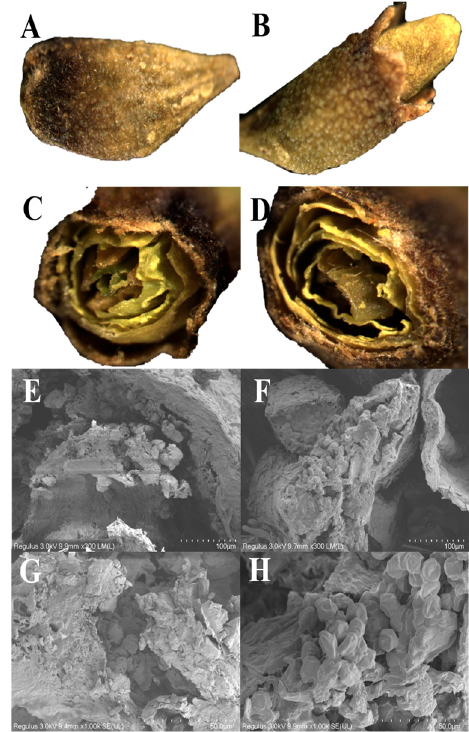
Figure 2. Stereomicroscope of ( A ) VD, 2×, ( B ) UAVD, 2×, ( C ) VD, 5×, and ( D ) UAVD, 5×. Scanning electron micrographs of ( E ) VD, 300×, ( F ) UAVD, 300×, ( G ) VD, 1000×, and ( H ) UAVD, 1000× at two different scales (0.1 mm and 50 μ m), showing the structural characterization of the FSI after ultrasonic-assisted treatment. UAVD, ultrasonic-assisted vacuum drying.